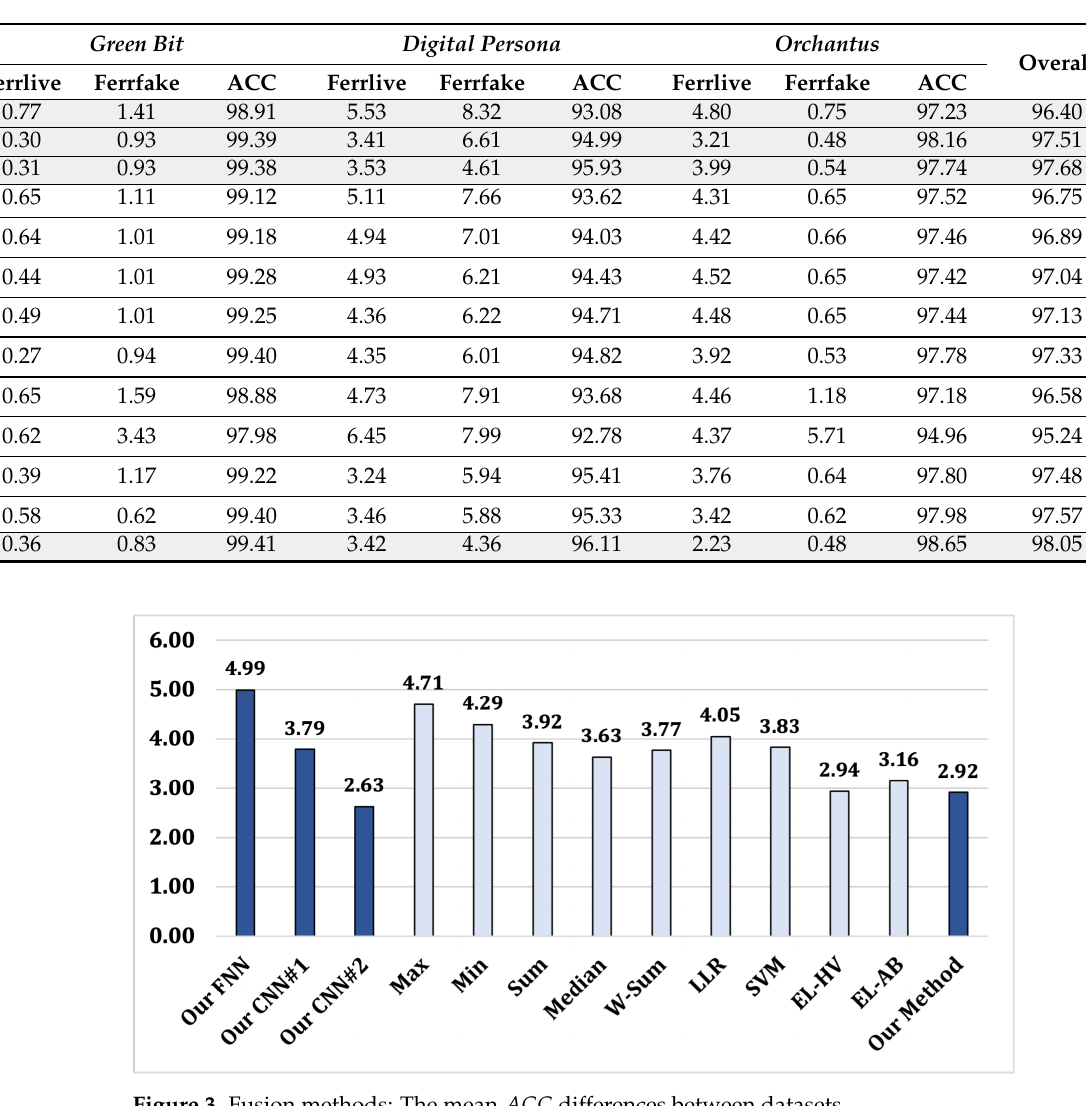
Table 2. The performance comparison between fusion methods.